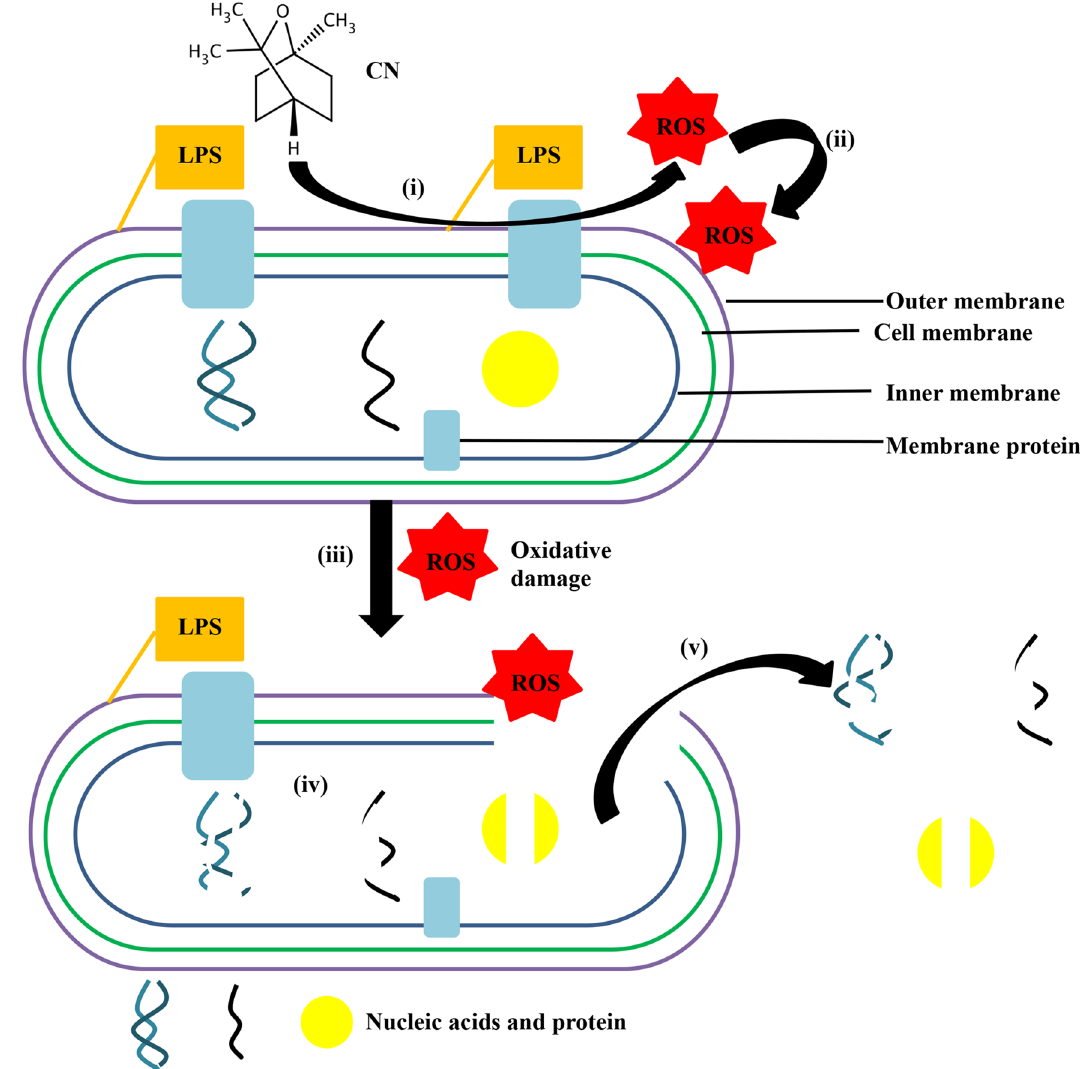
Figure 5. The proposed mode of action of CN against KPC-KP cells. ( i ) CN reacted with the bacterial membrane which produced ROS. ( ii ) ROS attacks membrane lipid to initiate lipid peroxidation, causing chain reaction which disrupts the bacterial membrane. ( iii ) The disrupted membrane leads to the influx of ROS into the intracellular region of KPC-KP. ( iv ) ROS degrades intracellular materials such as nucleic acids, proteins and lipids. ( v ) Intracellular materials leak out due to membrane